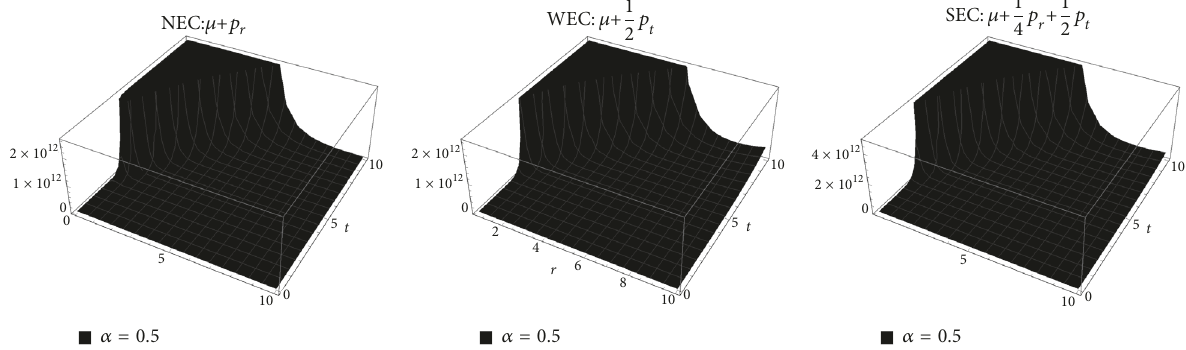
Figure 12: Plot of energy conditions along 𝑟 and 𝑡 for 𝑟 0 = 0.5